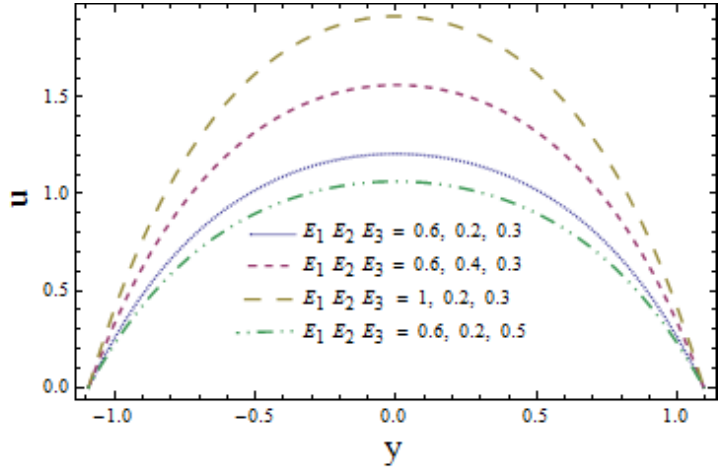
Figure 2. Velocity u versus y with E 1 , E 2 , E 3 when (cid:101) = 0.1, x = 0.2, t = 0.01, We = 0.03, n = 0.4, m = 0.04 and m 1 =